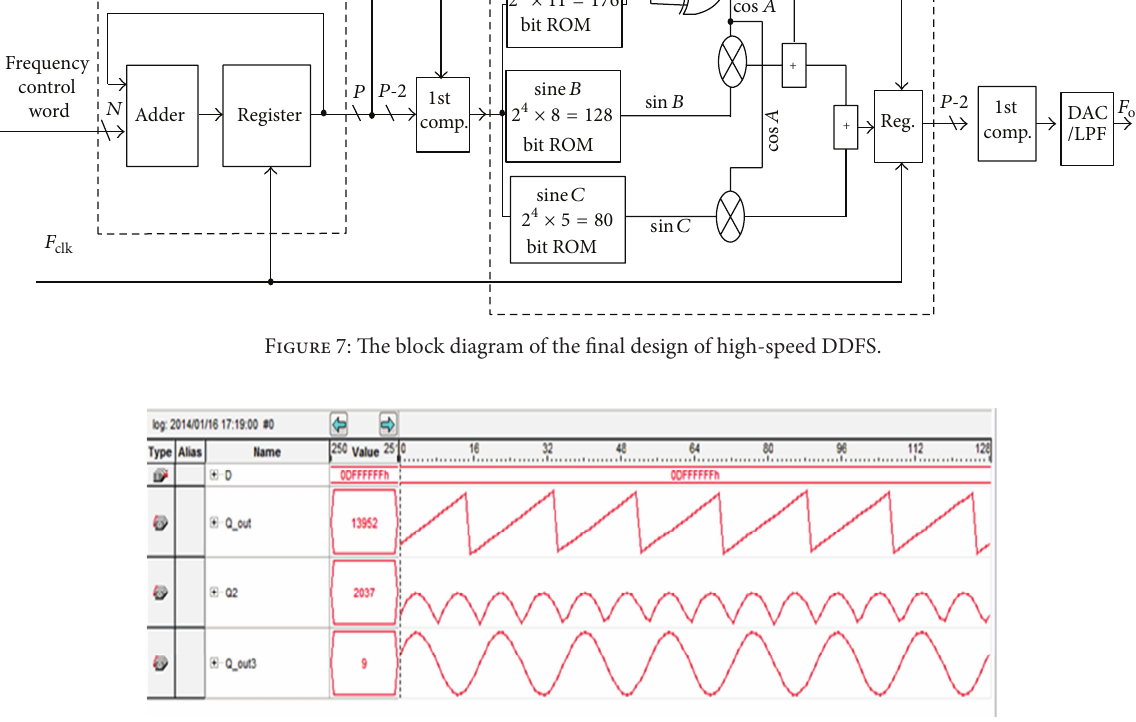
Figure 8: Signal tap logic analyzer of FCW input (in hexadecimal), the sawtooth PA output, and half and full amplitude waveform.